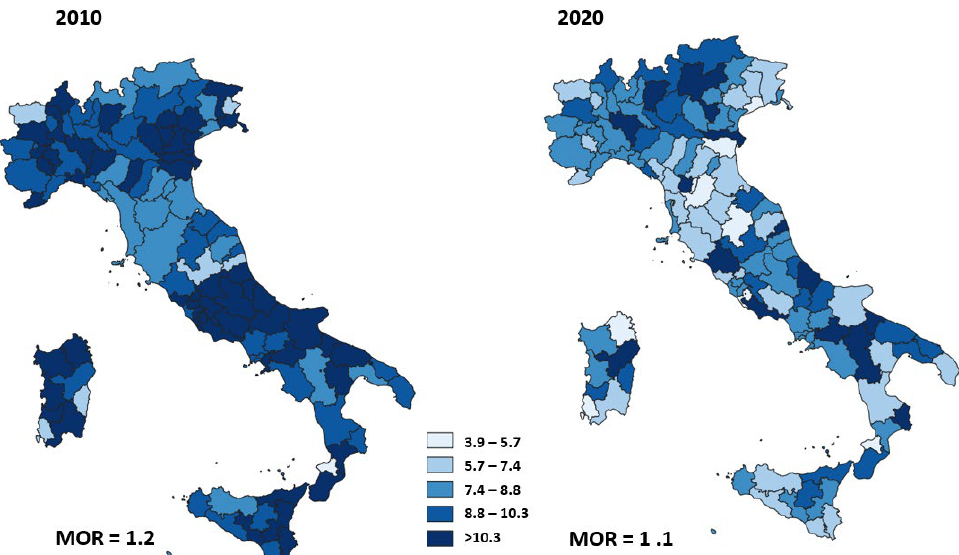
Figure 3. 30-day mortality rates after acute myocardial infarction. Italy, 2010–2020.